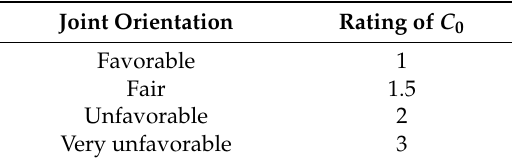
Table 8. Adjustment ratings for joint orientation.